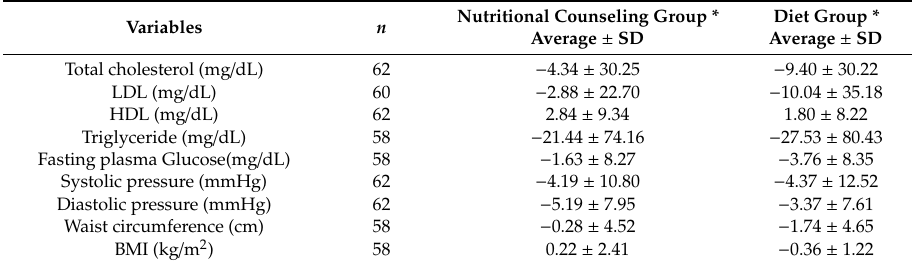
Table 3. E ff ectiveness of each nutritional treatment on cardiometabolic